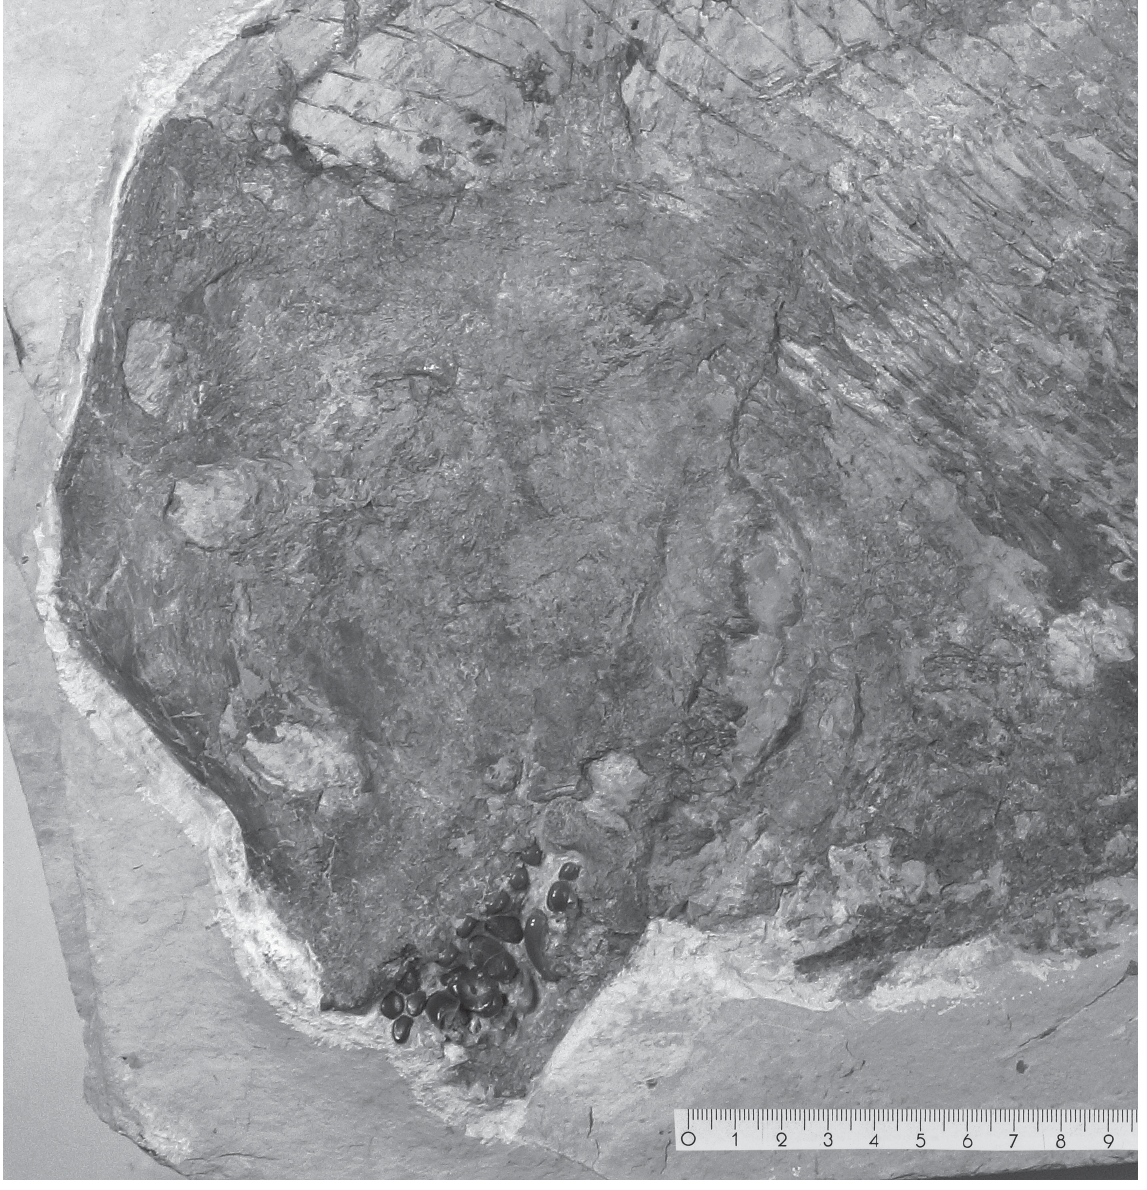
Fig. 15. Sigmapycnodus giganteus gen. et sp. nov., holotype, head region (CLC